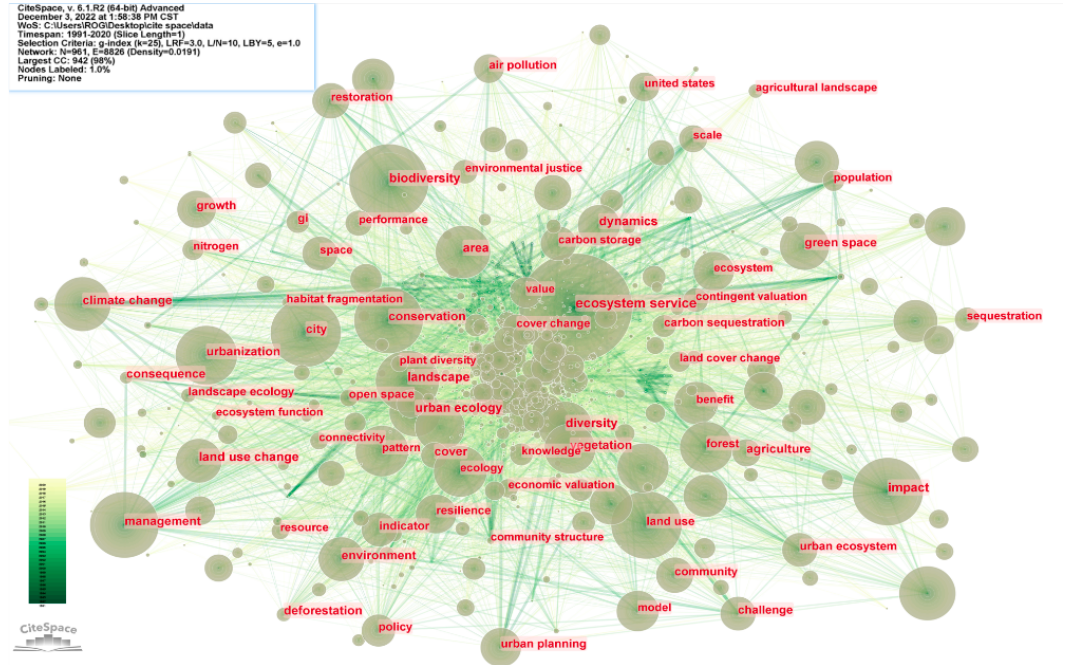
Figure 8. Map of keywords in the papers on UES during